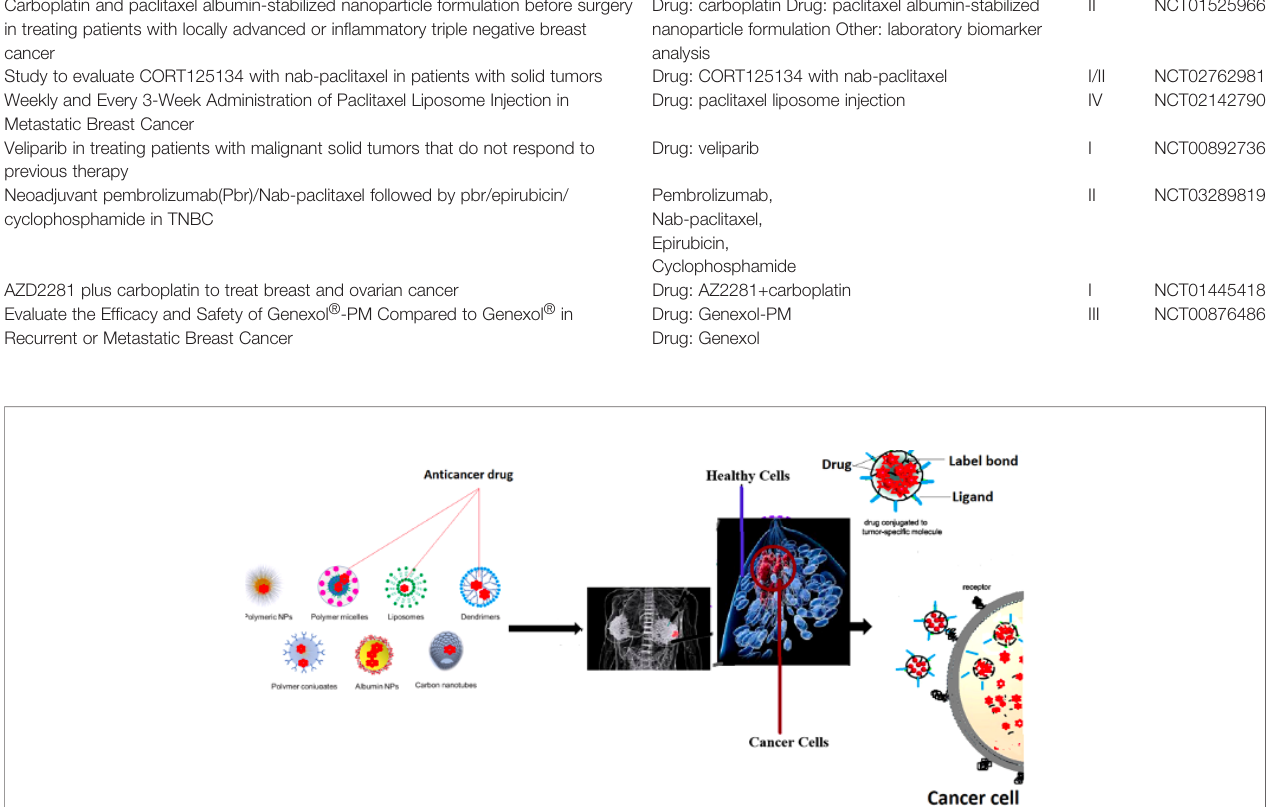
FIGURE 1 | Various Nanoparticles to treat Breast Cancer.